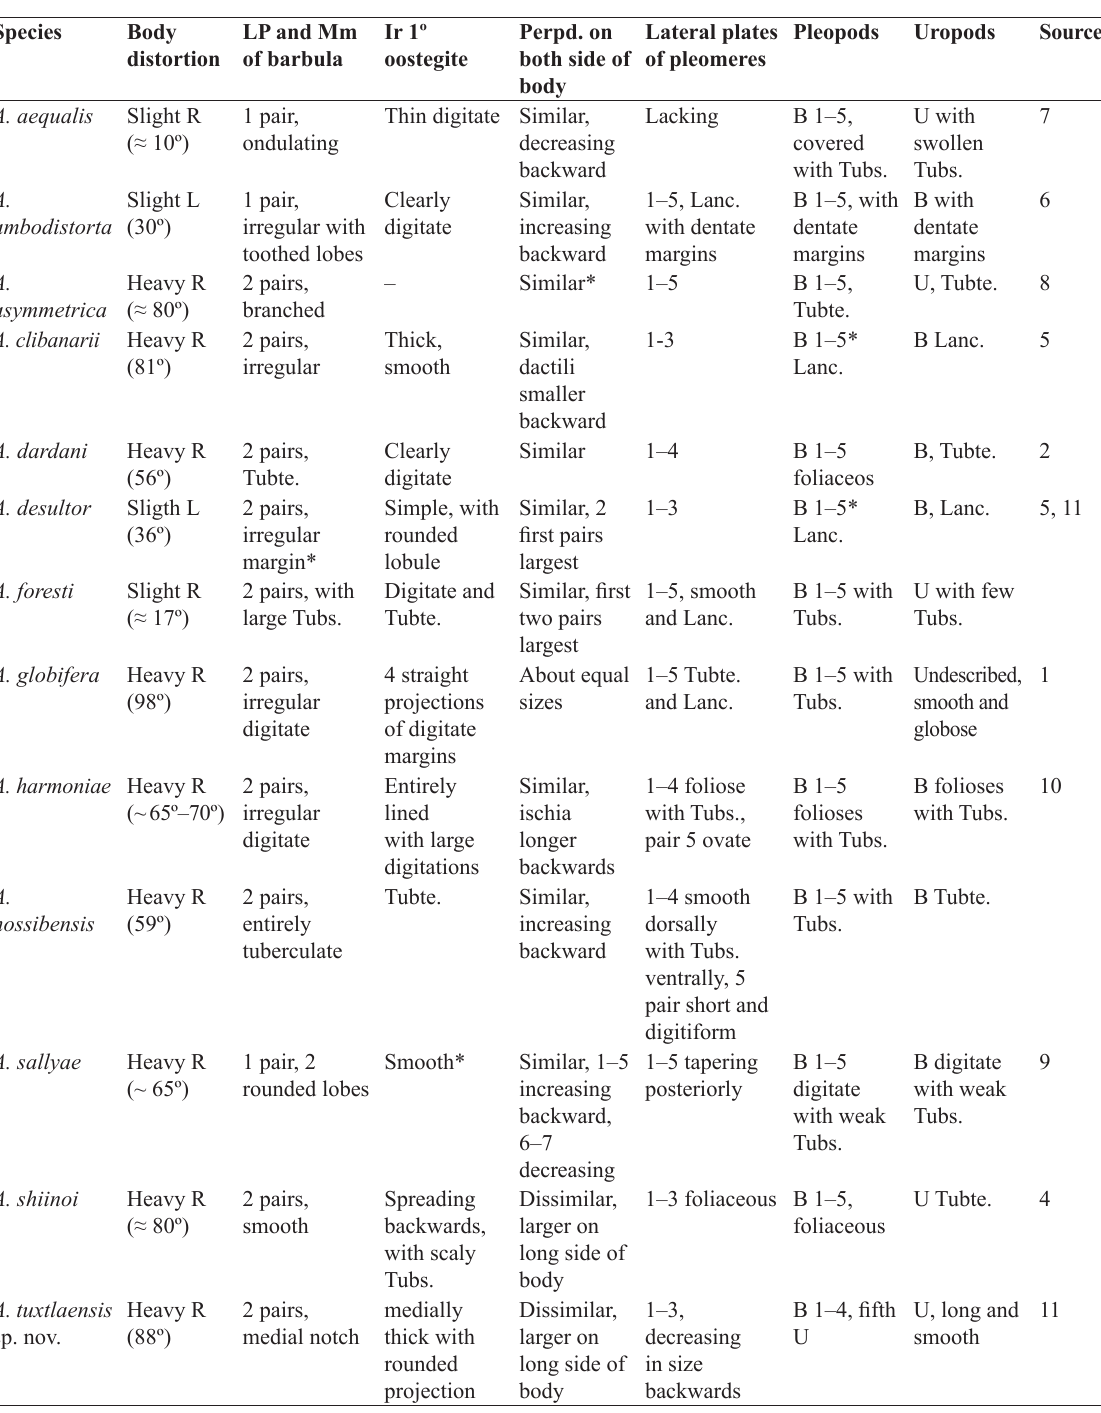
Table 2. Comparison of morphological traits comparison of female of Asymmetrione Codreanu, Codreanu & Pike, 1965. Abbreviations: B = biramous; L = left; Lanc. = lanceolate; LP = lateral projection; Mm = middle margin; Ir = inner ridge; Perpd. = pereopods; R = right; Tubs. = tubercles; Tubte. = tuberculate; U = uniramous; * based on illustrations provided in the holotype description. Sources: 1 = An et al . 2010; 2 = Bourdon 1968; 3 = Bourdon 1976; 4 = Codreanu et al . 1965; 5 = Markham 1975b; 6 = Markham 1985; 7 = Pardo et al . 2009; 8 = Shiino 1933; 9 = Williams & Schuerlein 2005; 10 = Williams et al . 2019; 11 = this